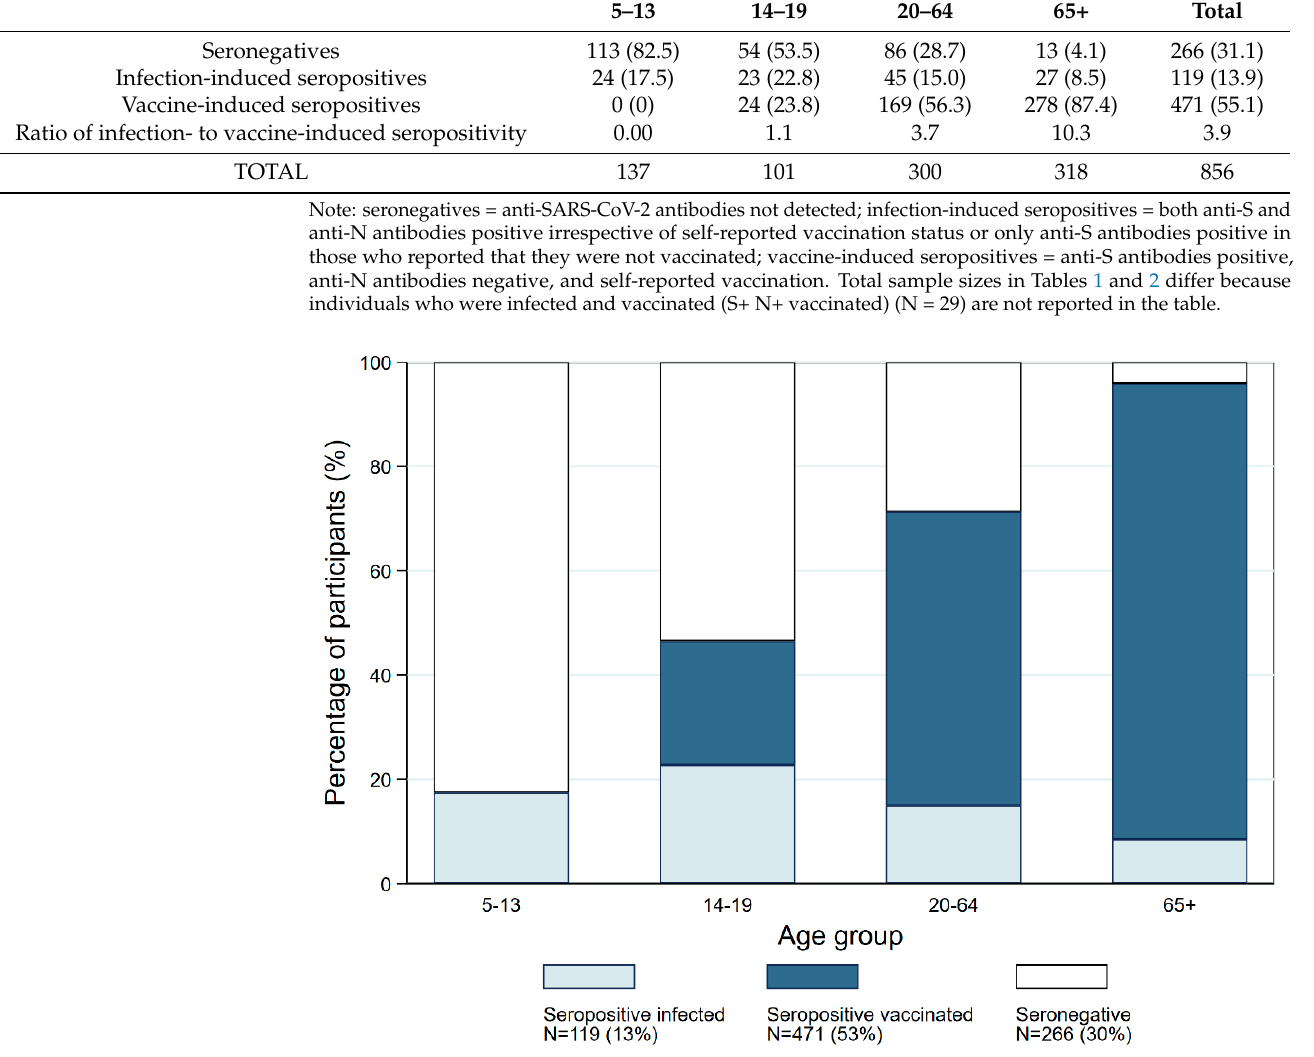
Figure 5. SARS-CoV-2 antibodies’ neutralizing activity by variant in the sub-sample of seropositive participants at the third serosurvey in June–July 2021 (N = 250).